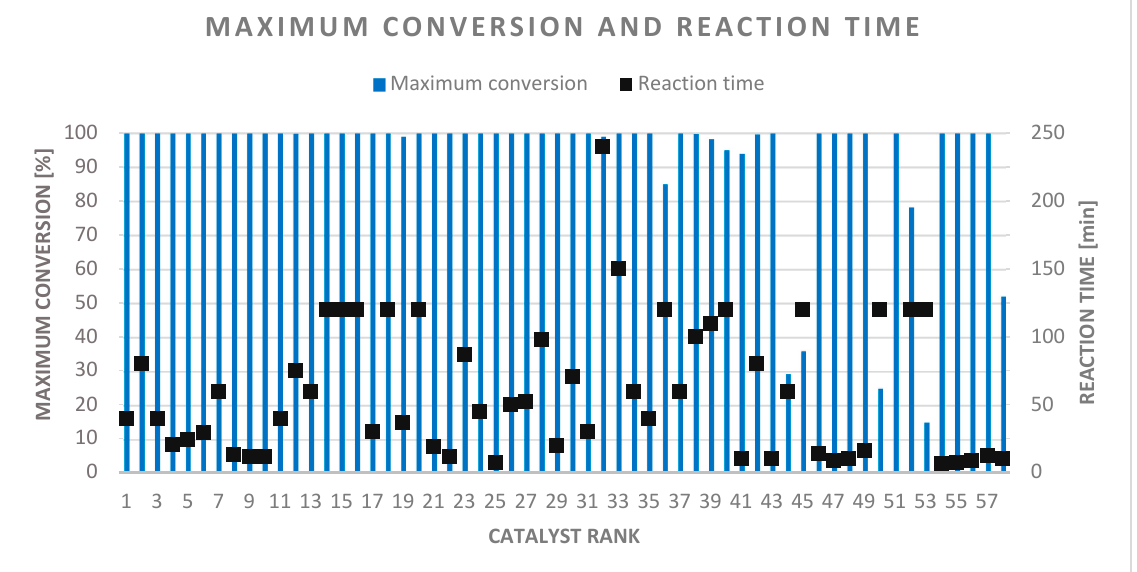
Figure 10. Maximum conversion with required reaction time .